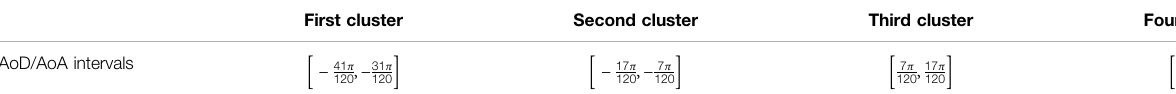
TABLE 1 | AoA/AoR interval ranges for cluster index modulation (CIM).